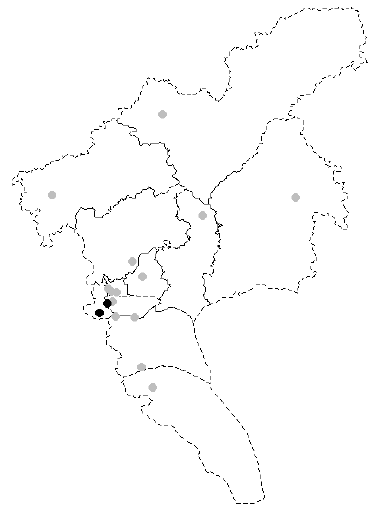
Figure 1. Geographic locations of 14 selected communities for the study (indicated by grey dots) and the two high-risk areas of COVID-19 in Guangzhou (indicated by black dots).